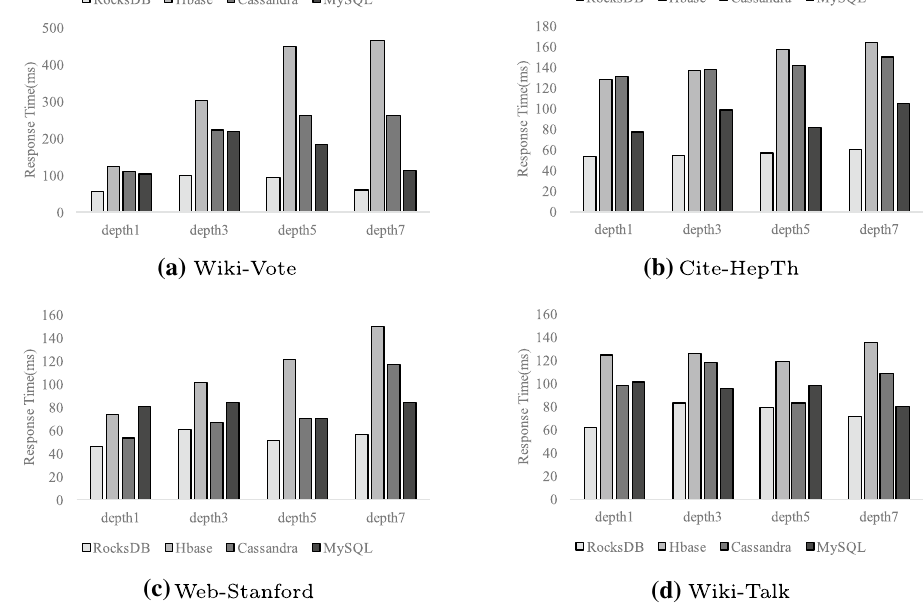
Fig. 4 Testing the shortest path algorithm over 4 back-end stor- age